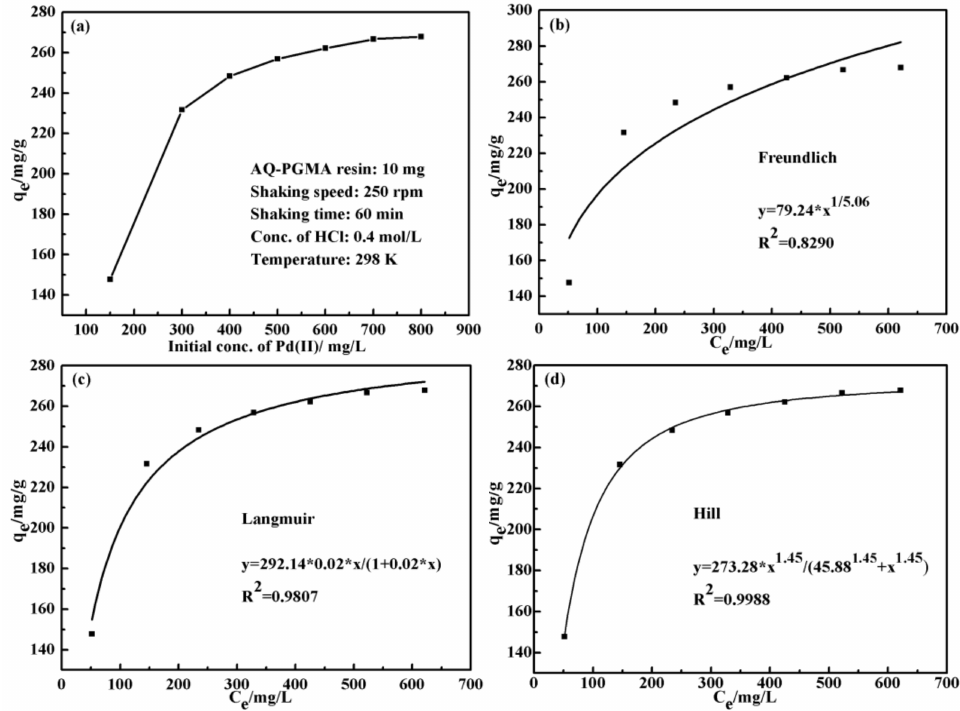
Figure 5. Effect of initial Pd(II) concentration on the adsorption of Pd(II) by AQ-PGMA ( a ) and adsorption isotherm models (Freundlich ( b ), Langmuir ( c ), Hill ( d